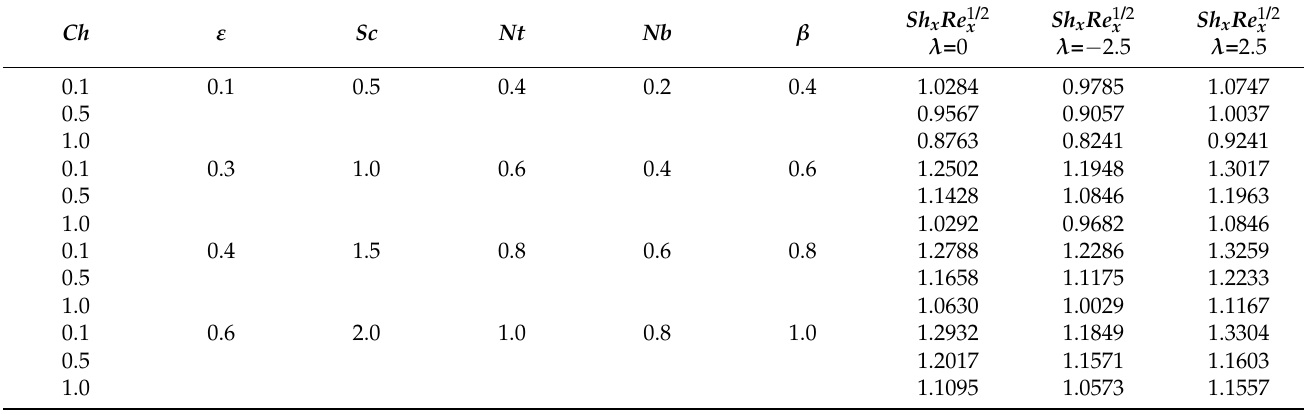
Table 4. Sherwood number for various physical variables.